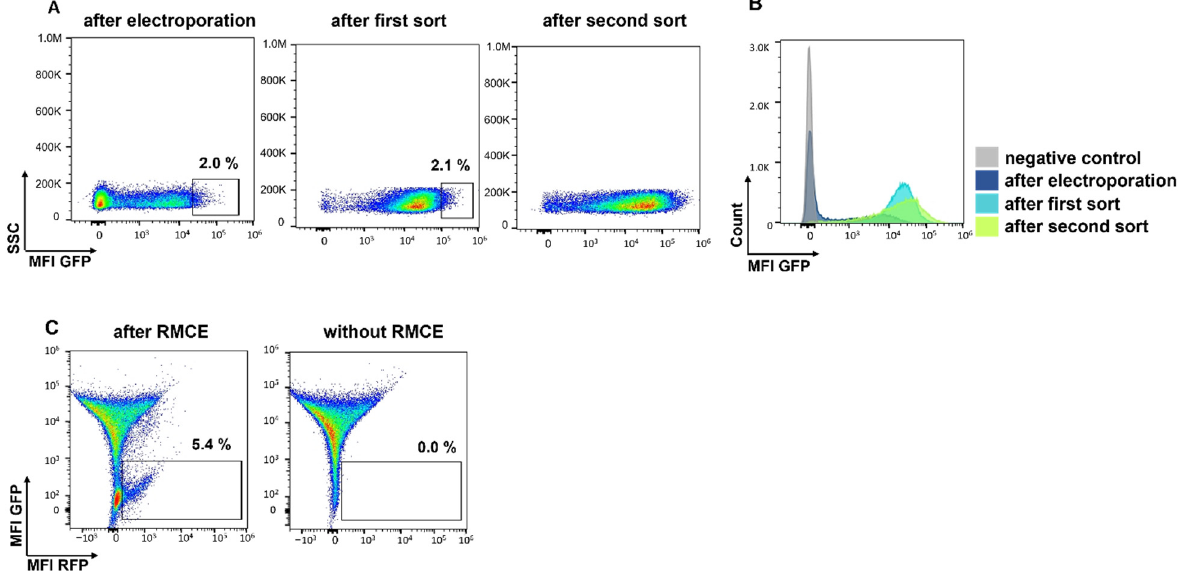
Figure 2 . Flow cytometric analysis of CHO cells during landing pad integration. ( A ) Gating strategy